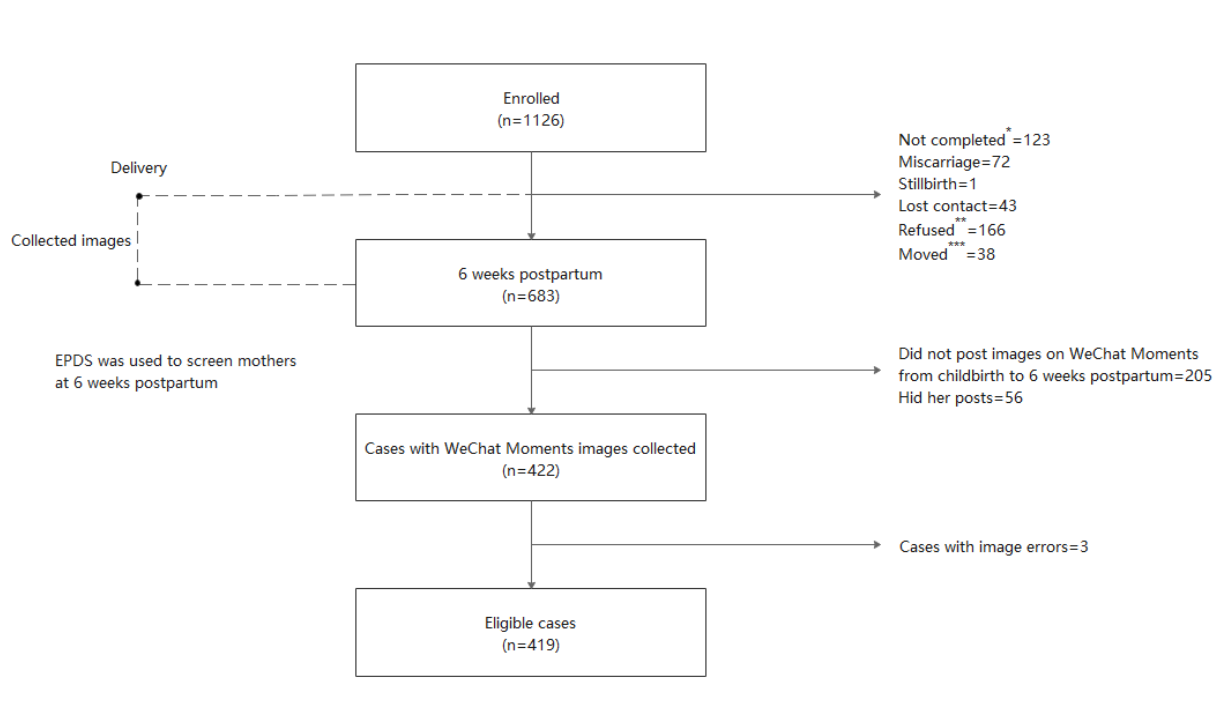
Figure 1. Participant recruitment and data collection process flow diagram. EPDS: Edinburgh Postnatal Depression Scale. *Mothers did not complete the EPDS at 6 weeks postpartum, **Mothers refused to participate in the investigation, ***Mothers moved to another city for childbirth and were unable to continue participating in the